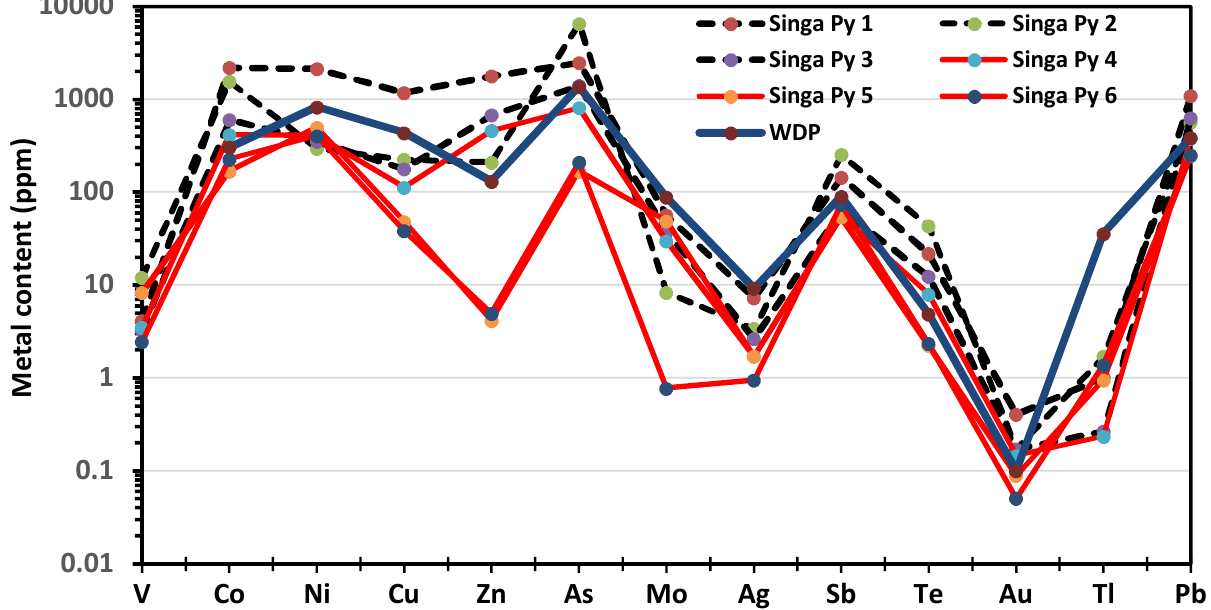
Figure 7. Mean trace element composition in pyrite (this study) from the Singa Formation, Malaysia. Note: WDP = World diagenetic pyrite (Gregory et al., 2015) [33]. Table 3. Pyrite trace element chemistry from the mudstones of the Singa Formation, Langkawi, Malaysia. BDL = below detection limit.